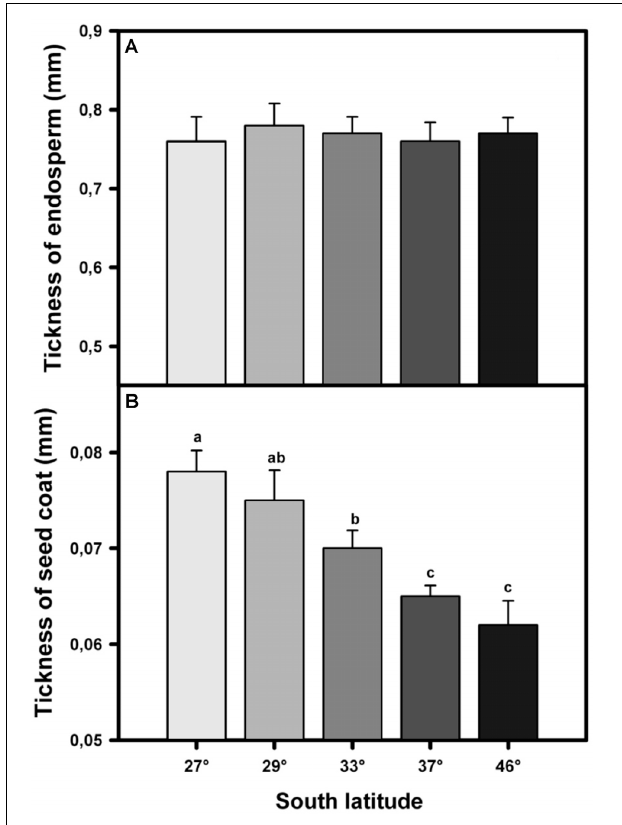
FIGURE 2 | Mean values ( ± 2 SE) of thickness of endosperm (A) and seed coat (B) in seeds of Taraxacum officinale collected from five localities along a latitudinal gradient. Significant differences between localities are denoted with different letters ( a posteriori Tukey test α =